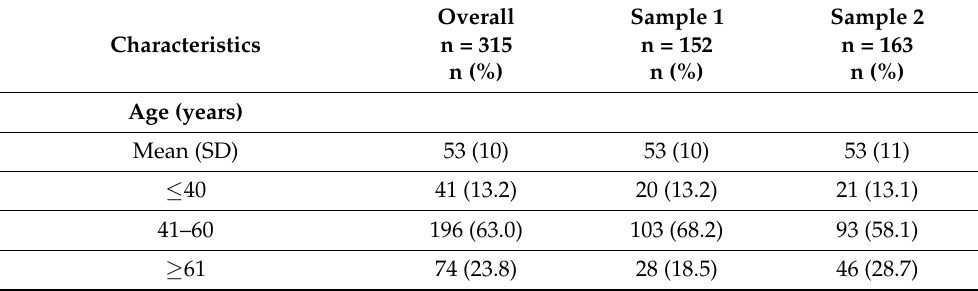
Table 3. Sociodemographic characteristics of study participants (n =